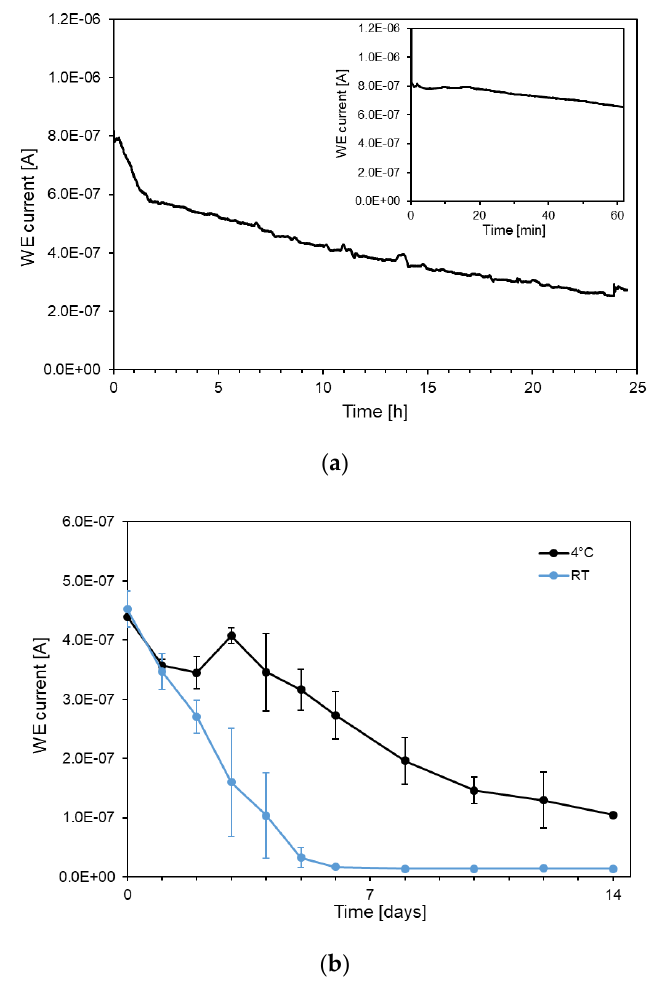
Figure 3 . ( a ) Continuous reading of the biosensor for 24 h (the first hour inserted) in 500 µM L-lactate PBS solution; ( b ) stability of the biosensors upon storage (14 days) in dry conditions at 4 °C and at room temperature (21 °C). All readings were performed in PBS solutions containing 500 µM of L- lactate.